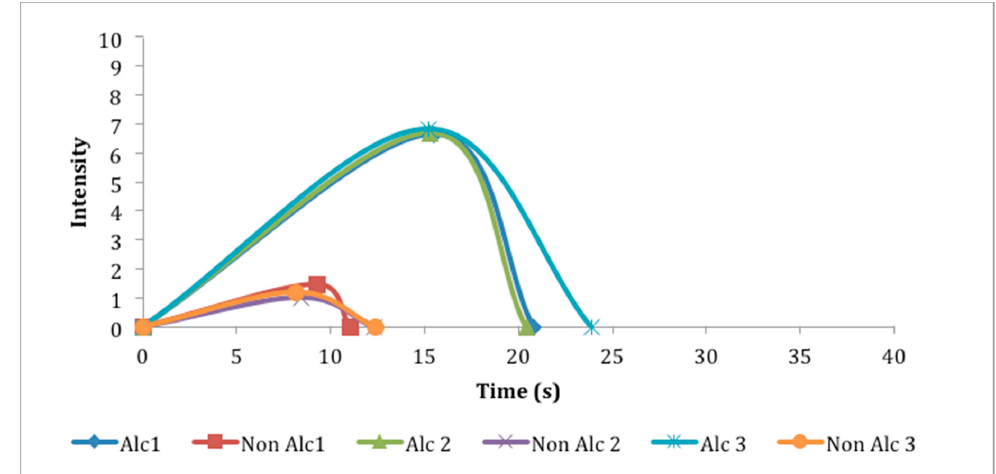
Figure 4. Time-intensity curves related to the alcoholic stimulus of Pilse beers of alcoholic and non- alcoholic beers. * Abreviations = Alcoholic Sample 1 (Alc1); Alcoholic Sample 2 (Alc2); Alcoholic Sample 3 (Alc3); Non-Alcoholic Sample 1 (Non Alc 1); Non-Alcoholic Sample 2 (Non Alc 2);